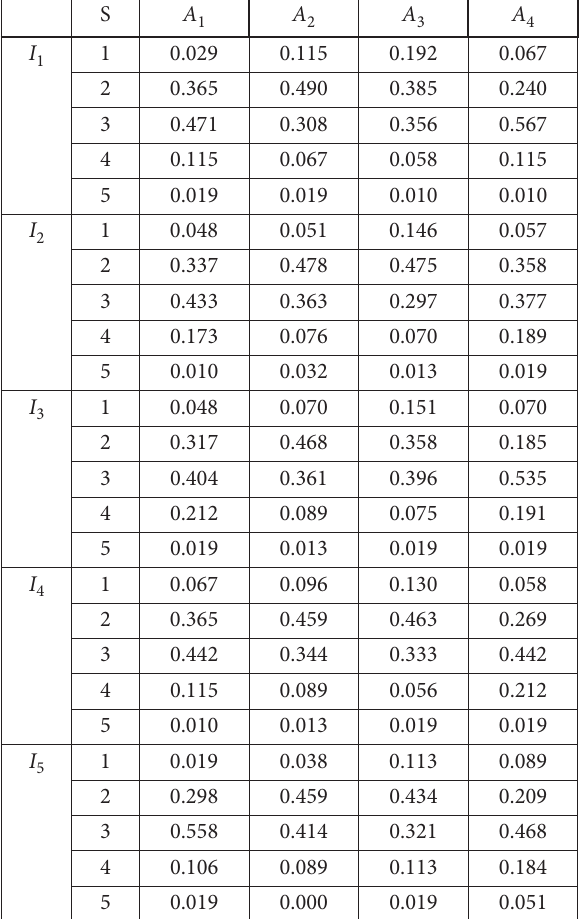
Table 6. Standardization of MIMS information for online reviews of public property service